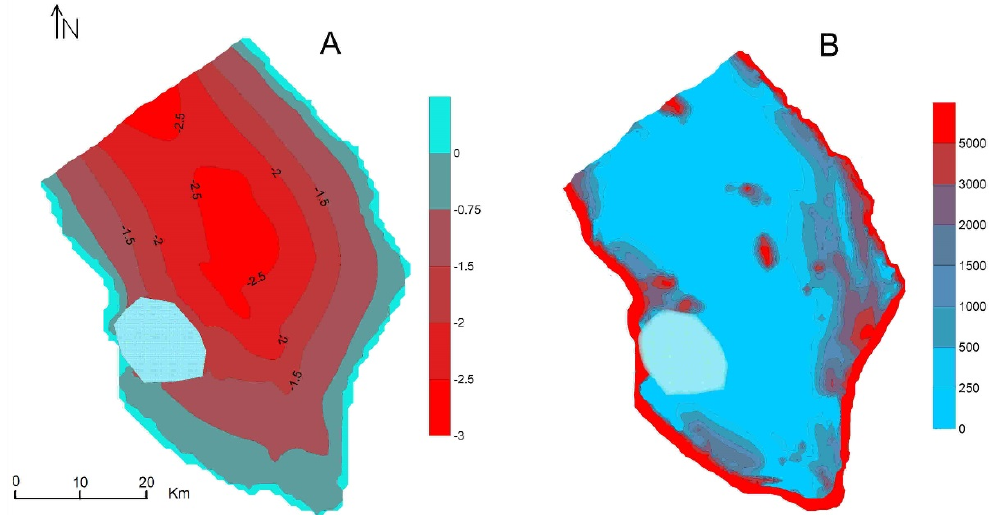
Figure 10. SS-HS piezometric ( A , m); and salinity ( B , mg/L) maps for a selected layer (layer − 50 to − 65 masl) for the year 2060, assessed according to the hypothesis of an unchanged discharge level observed at the beginning of the PTA application [33]; piezometric head and salinity increase with respect to natural or steady state values, based on data from the 1930s (after [16]). The light blue area denotes the shallow aquifer.